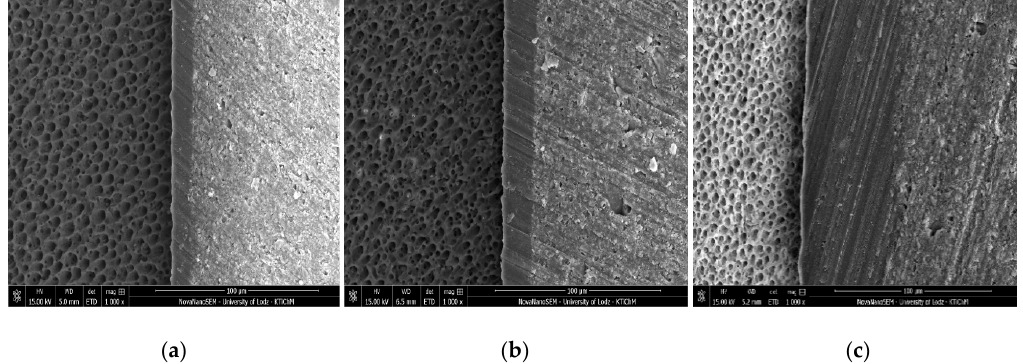
Figure 3. SEM images of adhesive layers obtained by application of Single Bond Universal: ( a ) one layer; ( b ) two layers; ( c ) three layers; mag. 1000x.